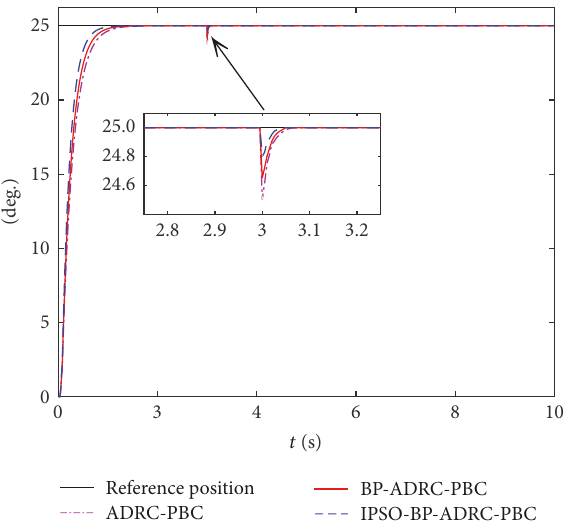
Figure 8: Step response curve with load disturbance.